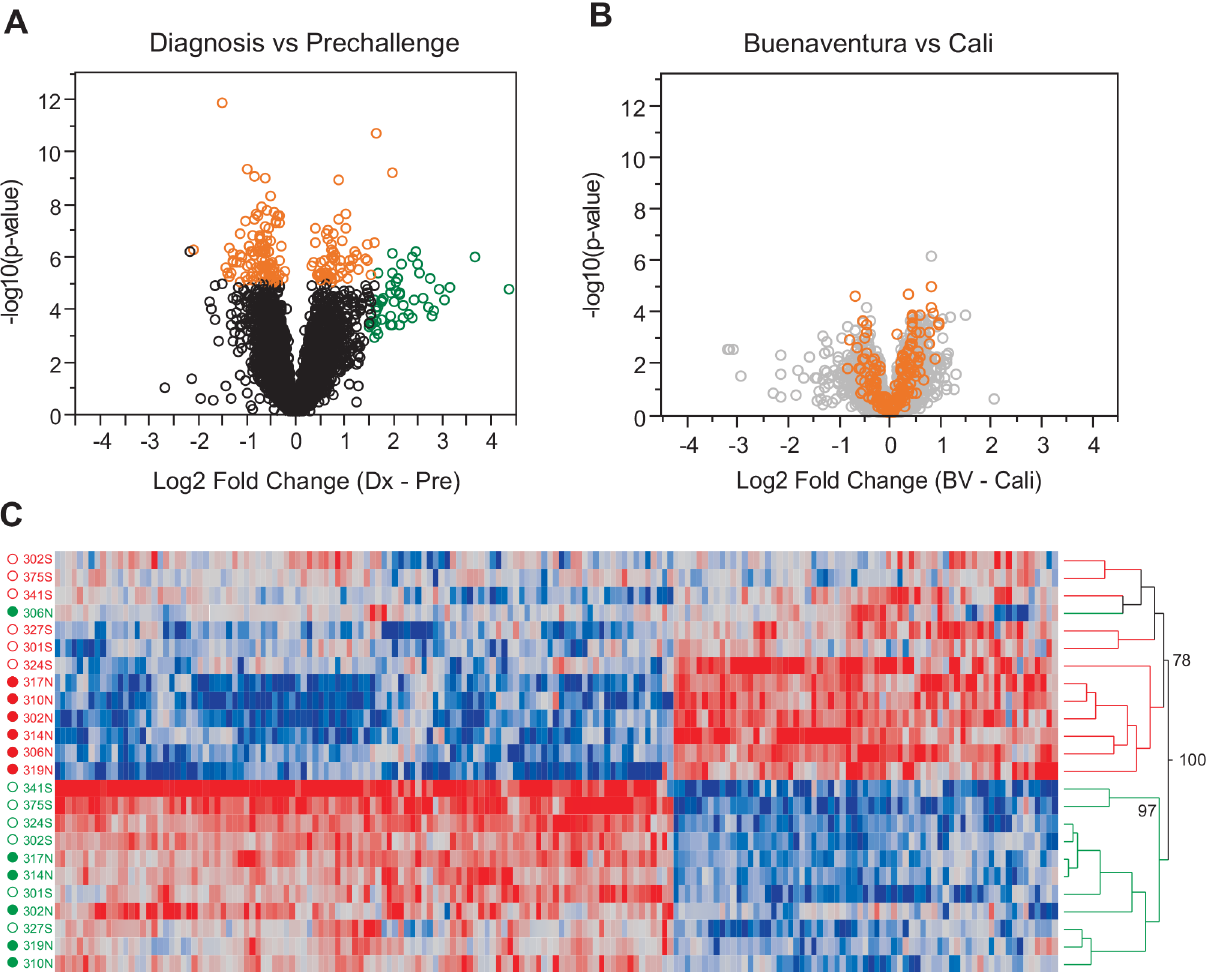
Fig 4. Differential expression in whole-blood RNASeq data set. Volcano plots of statistical significance vs. magnitude of differential expression for the contrasts between timepoint in (A) and by location in (B), highlighting significant genes for the timepoint effect in orange. Y axis shows the significance as – log10 P value, and x-axis shows the magnitude of the difference log2 units (highlighting significant genes at NLP > 5 for the timepoint contrast). (C) Heat map showing two-way hierarchical clustering of transcripts (columns) in each sample (rows) of 175 genes that show a significant timepoint-by-location interaction effect at p < 0.05. Red cells indicate high expression, blue low, gray intermediate. Green sample labels represent Baseline (Pre-challenge) and red labels represent Diagnosis day, solid points represent Cali (N, na ï ve), and open circles represent Buenaventura (S, semi-immune). Approximately unbiased bootstrap support (AU) values computed with pvclust are indicated beside three deep